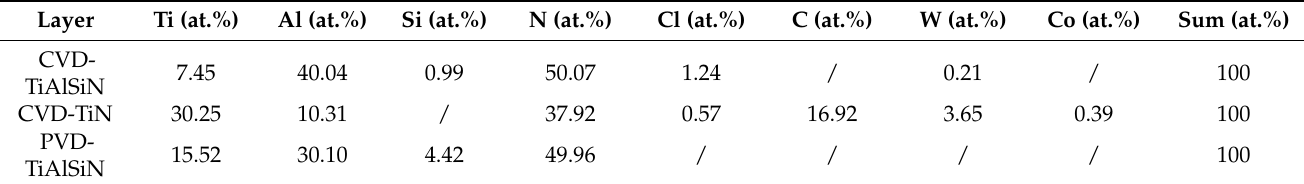
Table 1. Compositions of CVD and PVD TiAlSiN coatings